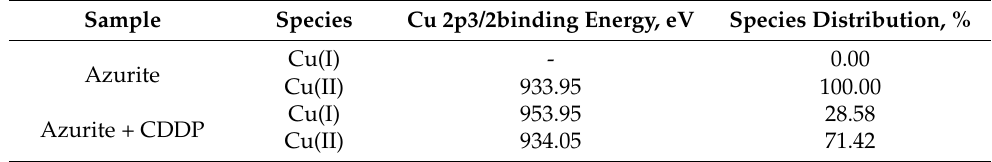
Table 3. Quantification of Cu 2p species in azurite and CDDP-treated azurite samples.